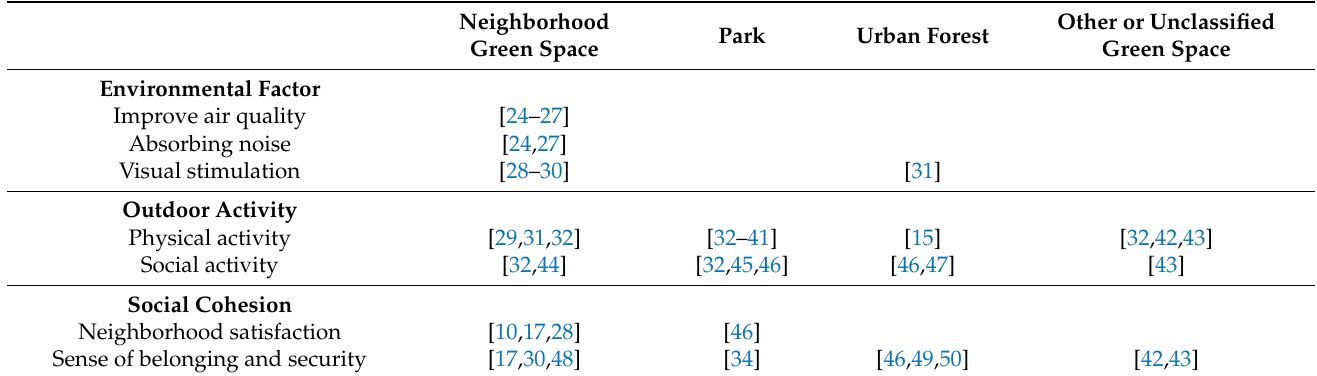
Table 1. Summary of selected articles based on types of green space and